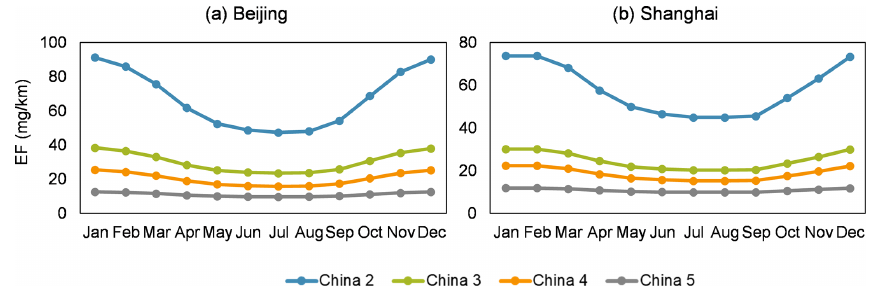
Figure 4. Monthly NH 3 EFs for LDGVs of various emission standards in (a) Beijing and (b) Shanghai in 2019.